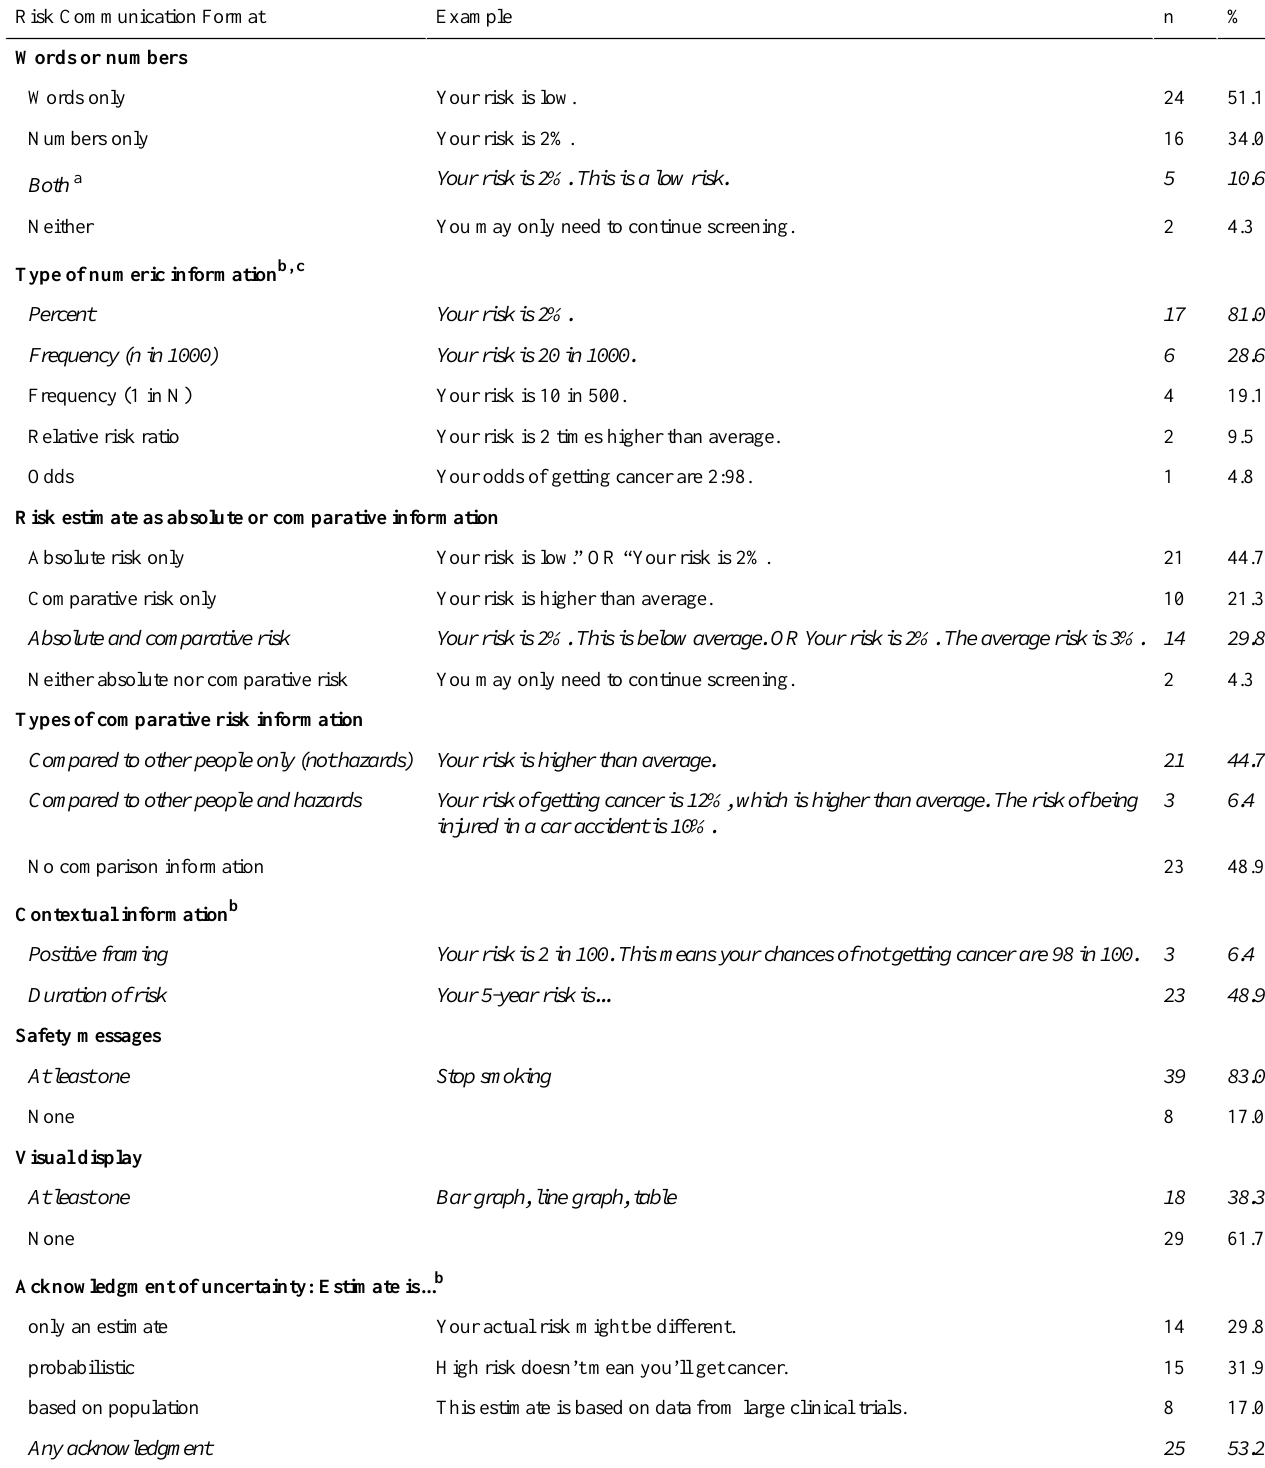
Table 5. Risk communication formats used by Internet-based cancer risk assessment tools to communicate individualized risk estimates (N =